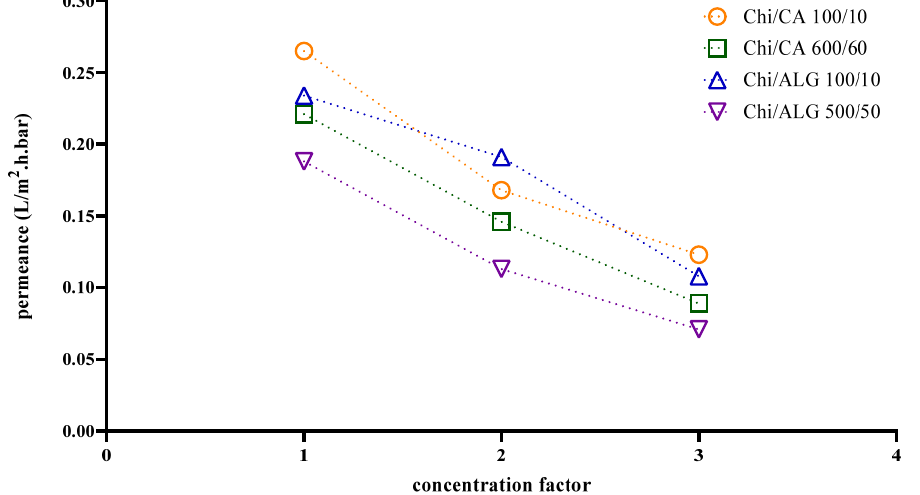
Figure 10. Membrane permeance as a function of volumetric concentration factor for different coagulant/flocculant combinations. Chi—Chitosan; CA—Carrageenan; ALG—Alginate.